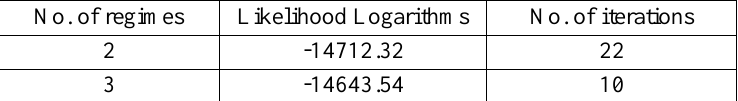
Table 3: Likelihood Logarithms for two estimators of the model (authors’